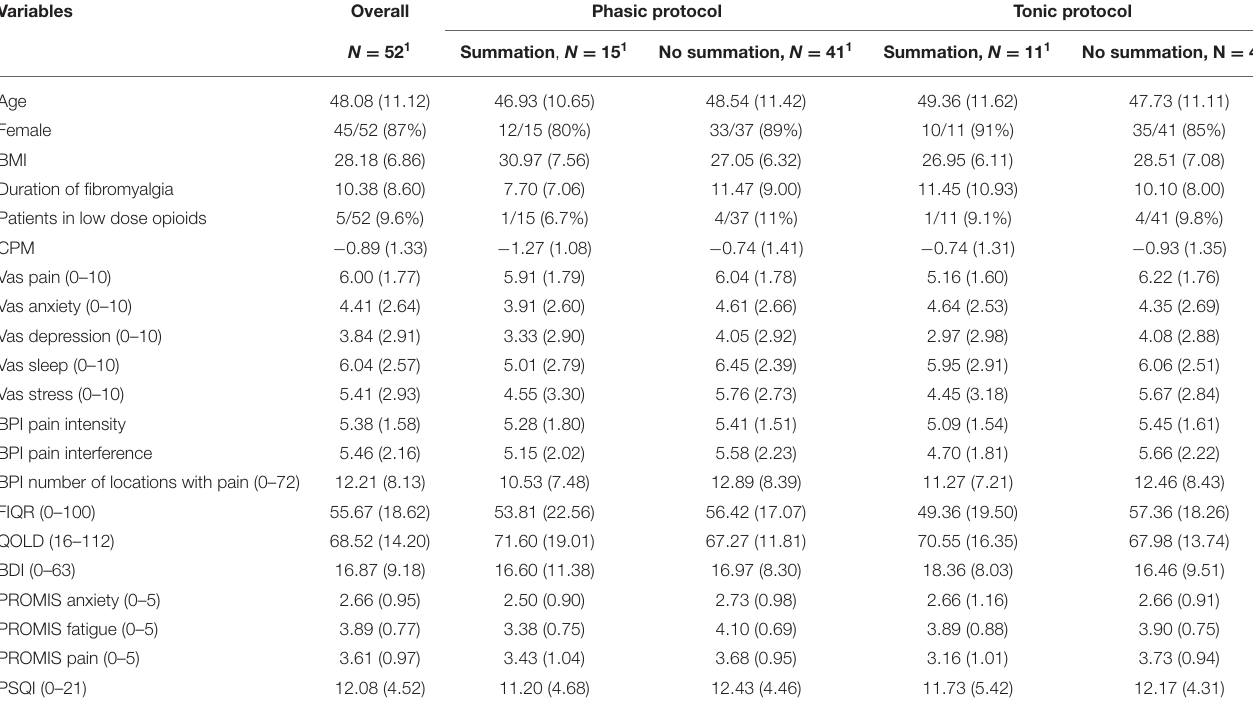
TABLE 1 | Baseline characteristics of the